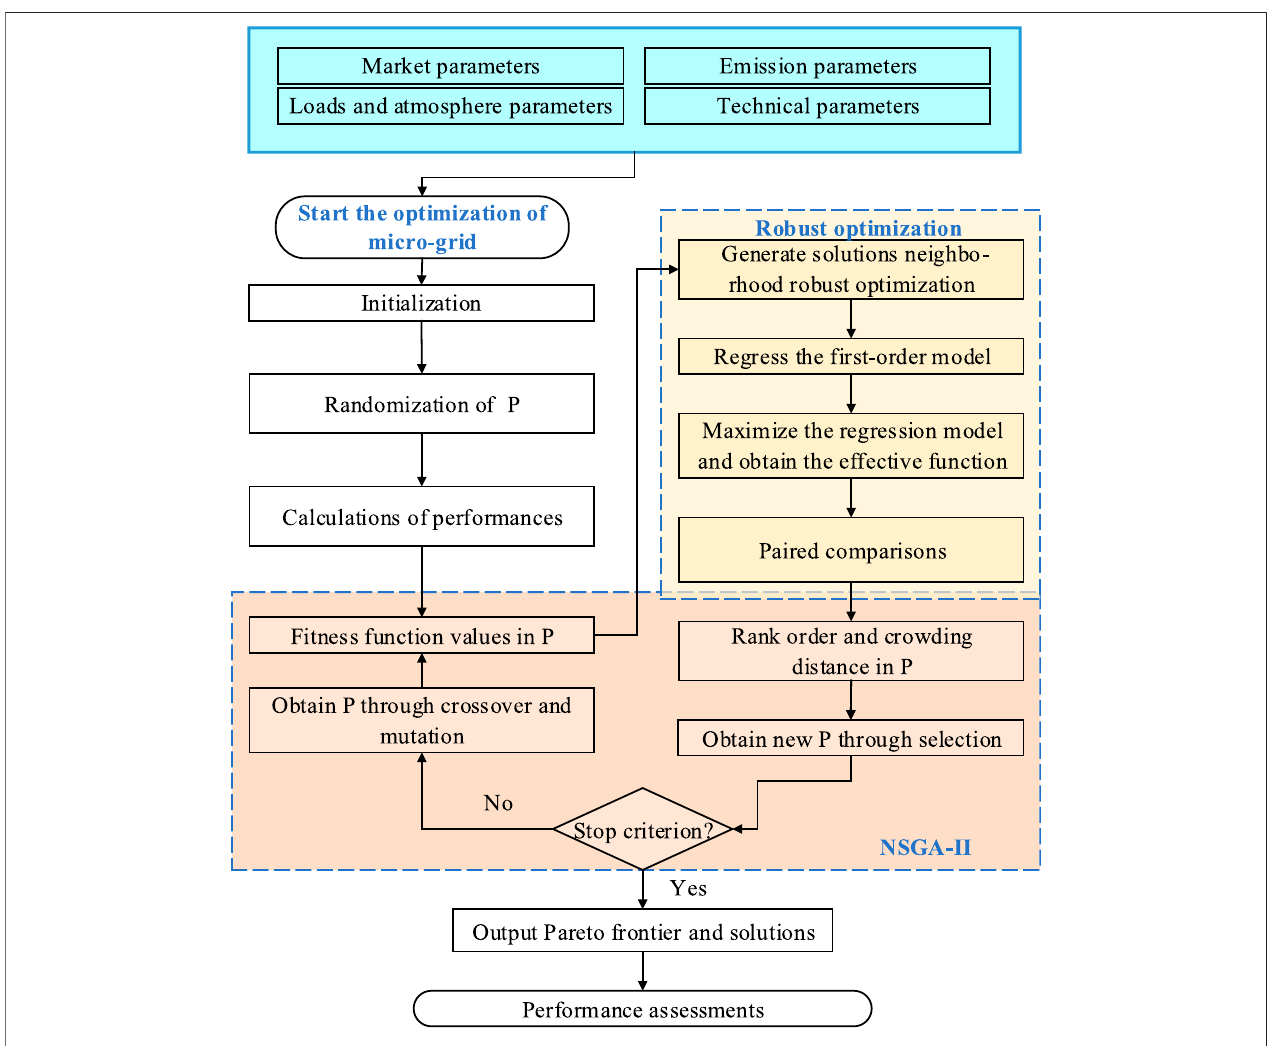
FIGURE 2 | Robust NSGA II